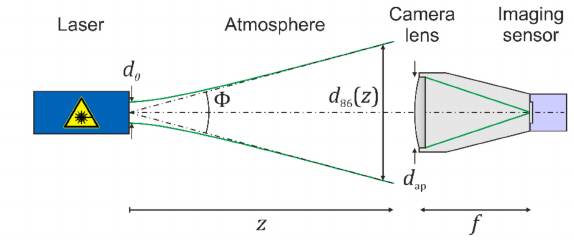
Figure 2. Schematic view of a dazzling